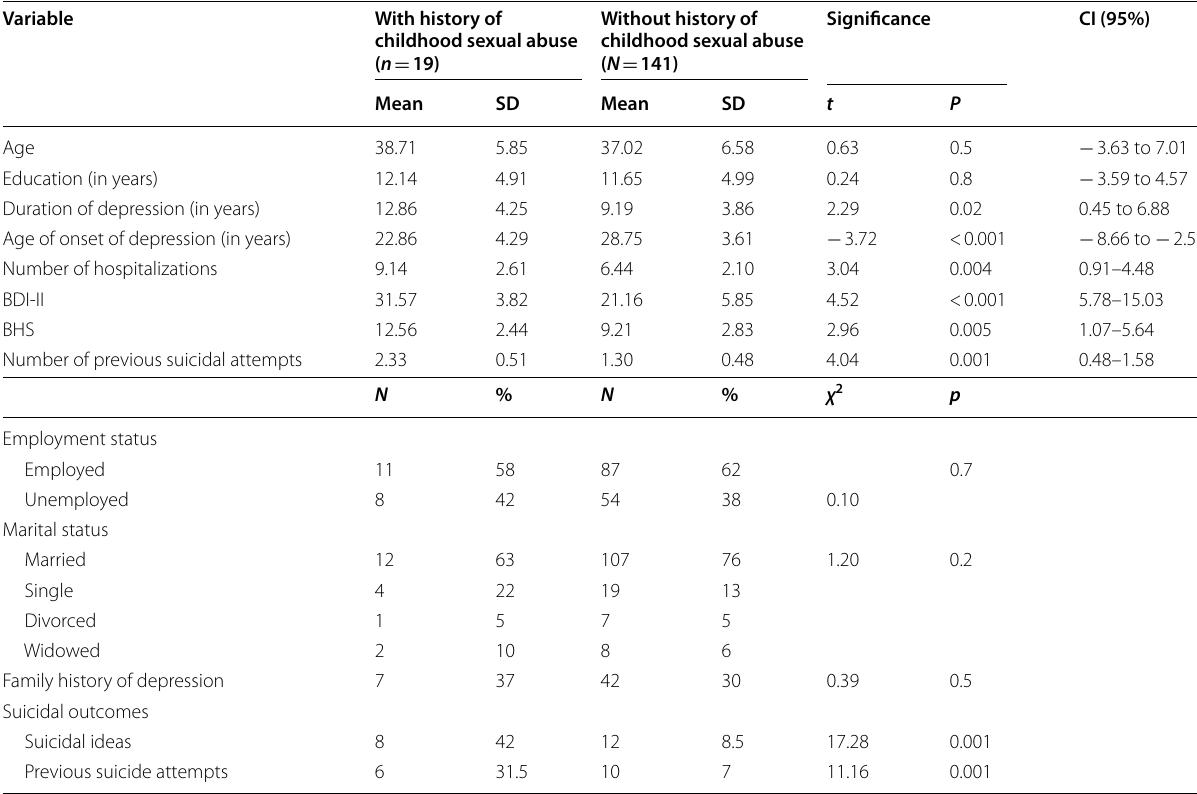
Table 1 Demographic and clinical characteristics comparison of depressed women with and without history of childhood sexual abuse ( n 160) =